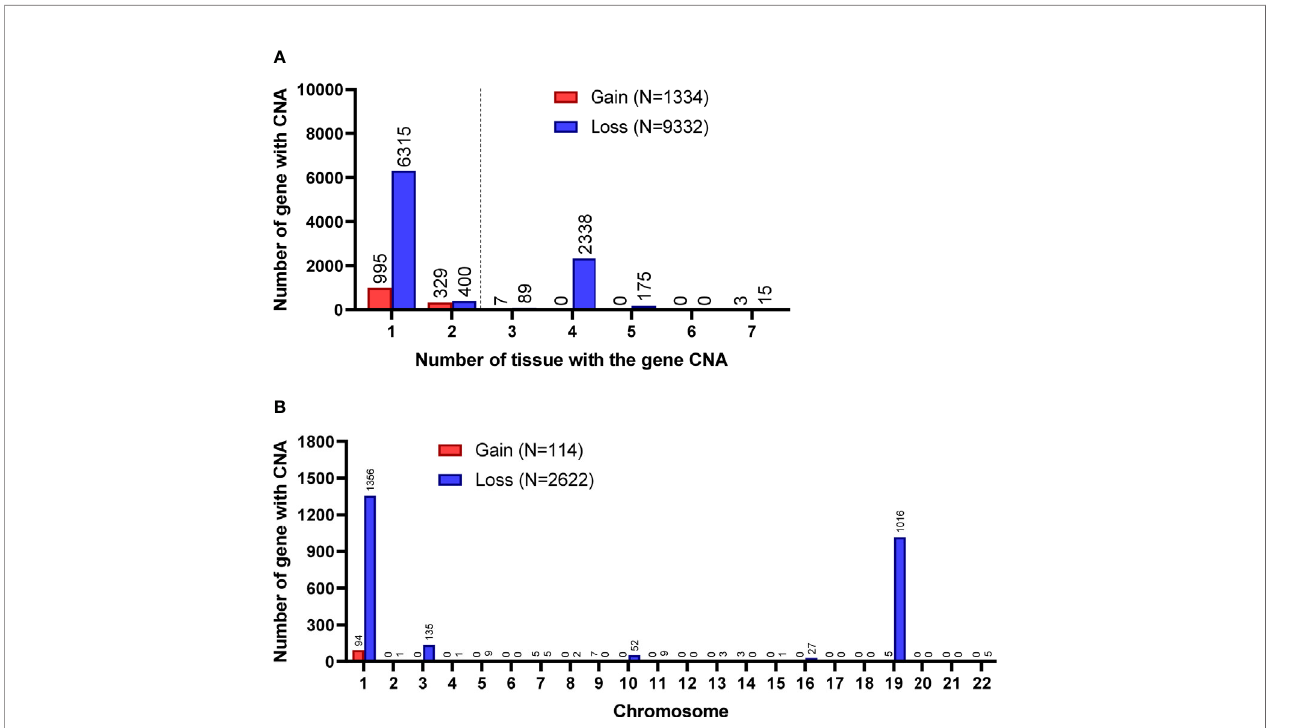
FIGURE 2 | Gene CNAs in parental WHO grade II/III glioma specimens. (A) Number of tumors contains genes with CNA in patient specimens. Genes with CNA in more than two tissue specimens were enrolled in the following studies. (B) The distribution of genes with CNA on chromosomes.